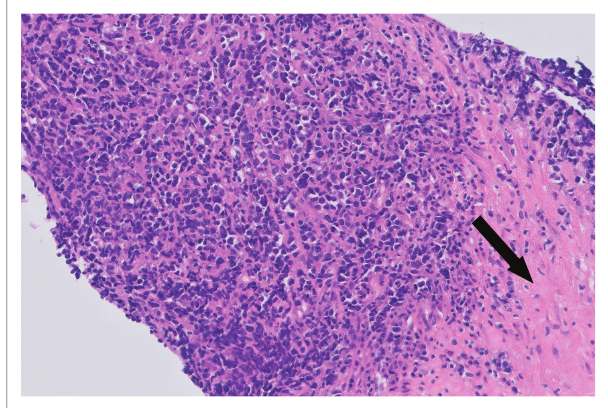
FIGURE 4: Histological image (Hematoxylin and eosin staining, enlargement 200x) showing compact growth of the high-grade small blue round cell tumour with focal desmoplasia